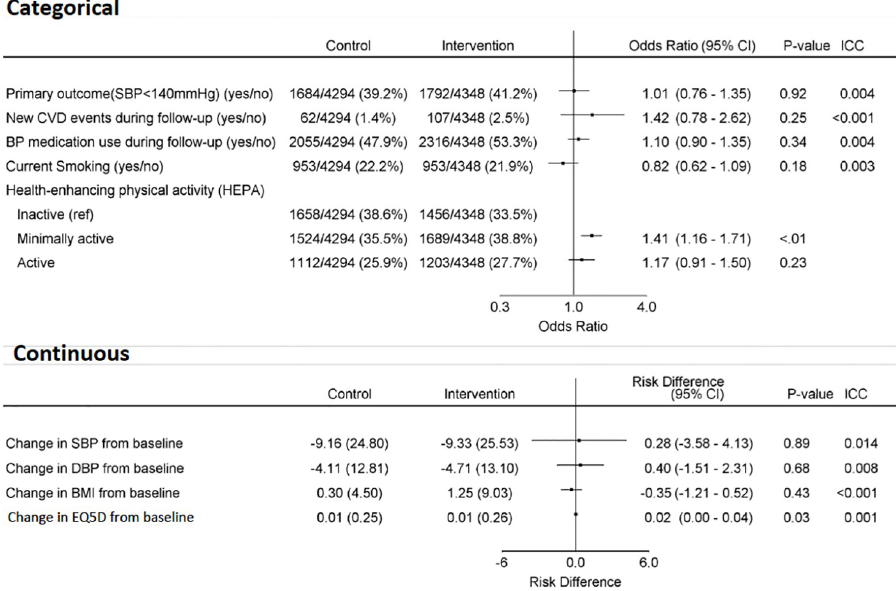
Fig 3. Primary and secondary outcomes by randomization period. SBP: systolic blood pressure; CVD: cardiovascular disease; DBP: diastolic blood pressure; BMI: body mass index; EQ5D: EuroQol quality of life instrument; ICC: intraclass correlation coefficient.